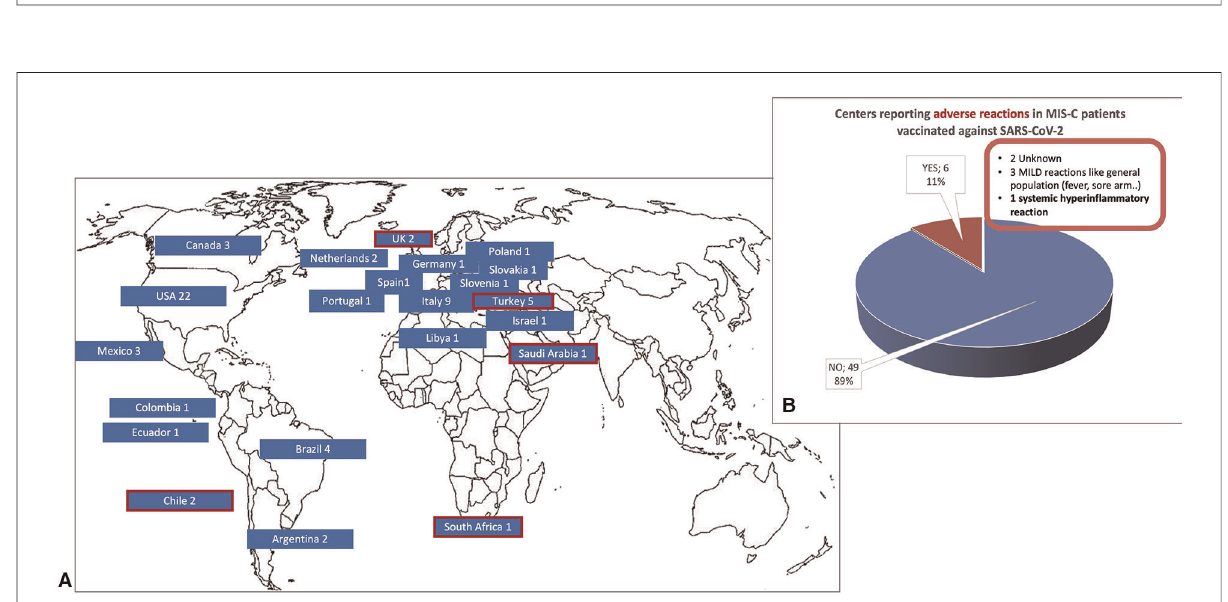
FIGURE 1 World map showing the 61 countries that participated to the survey, including the number of physicians, the number of centers involved, the countries in which the vaccination was not available for children or for individuals younger than 16 years.